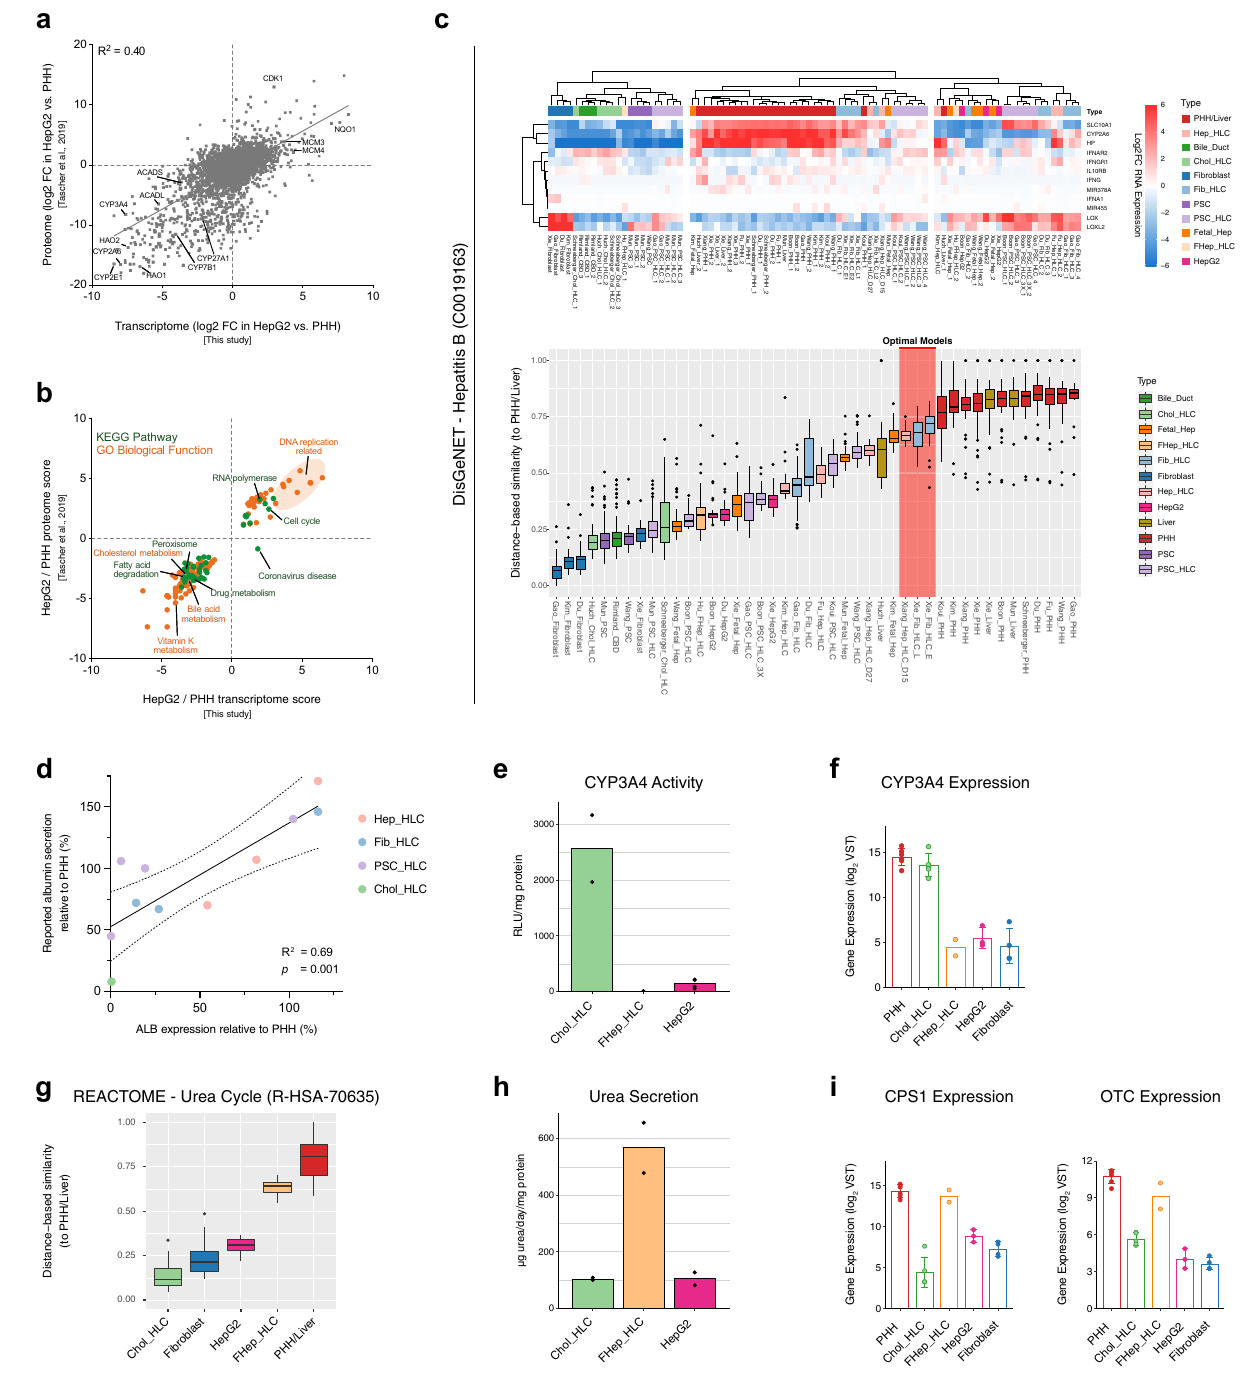
Fig. 4 Transcriptomic comparison allows prediction of HLC functionality. a Scatter plot of protein abundance ratios against corresponding mRNA ratios in HepG2 cells vs. PHHs for proteins/genes that are detected in both transcriptome (from our transcriptomic comparison) and proteome (from Tascher et al. 68 ). Pearson ’ s coef fi cient of determination ( R 2 ) is shown at the top left of the plot. b Scatter plot of enriched pathways based on transcriptome and proteome. Only pathways that are enriched on both the transcriptomic and proteomic levels are shown. c Heatmap and DBS of hepatitis B associated genes according to the DisGeNET database. Red highlight indicates the predicted optimal hepatocyte in vitro models. d Correlation plot of the gene expression levels of ALB from the transcriptomic comparison data ( x -axis) and the reported relative albumin secretion (y-axis) in included HLCs. Pearson ’ s coef fi cient of determination ( R 2 ) and P value ( p ) are shown on the bottom right of the graph ( n = 11 biologically independent samples). Dotted lines represent the 95% con fi dence interval. e CYP3A4 activities presented as mean. f Gene expression level of CYP3A4 from the transcriptomic comparison data presented as mean ± standard deviation. g The DBS of urea cycle genes according to the Reactome database. The combined values of Chol-HLC, fi broblast, HepG2 cell, FHep-HLC, and PHH/liver samples from different studies are presented. h Urea secretion level presented as mean. i Gene expression level of CPS1 and OTC from the transcriptomic comparison data presented as mean ± standard deviation. Box-and-whisker plots are shown as median (line), interquartile range (box), and data range or 1.5x interquartile range (whisker). Source data are provided in Supplementary Data